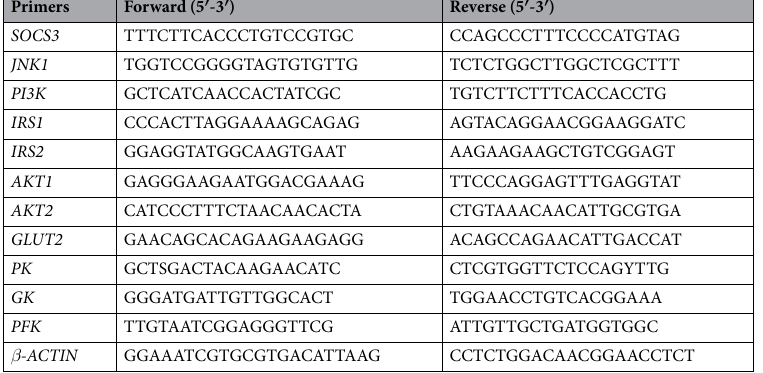
Table 6. List of PCR primer pairs used for the real-time PCR